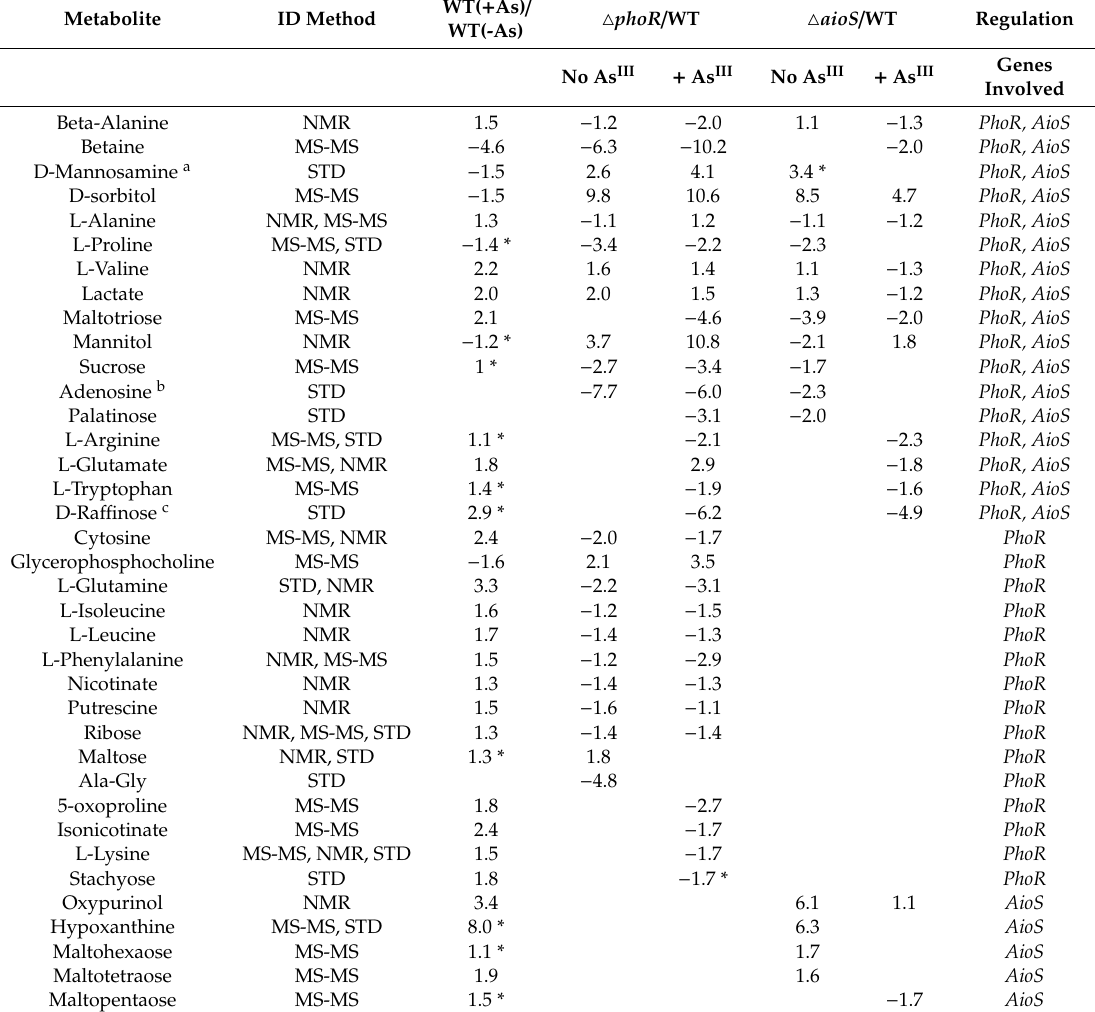
Table 1. Metabolites identified by liquid chromatography-mass spectrometry (LC-MS) and 1 H nuclear magnetic resonance (NMR) in wild-type (WT) and mutants, with data represented as fold changes. Only fold changes associated with a p-value ≤ 0.05 are listed, unless otherwise noted. Metabolites are classified by regulators that appear to be involved in expression (PhoR and / or AioS). STD = LC-MS identification by authentic standard database (MS